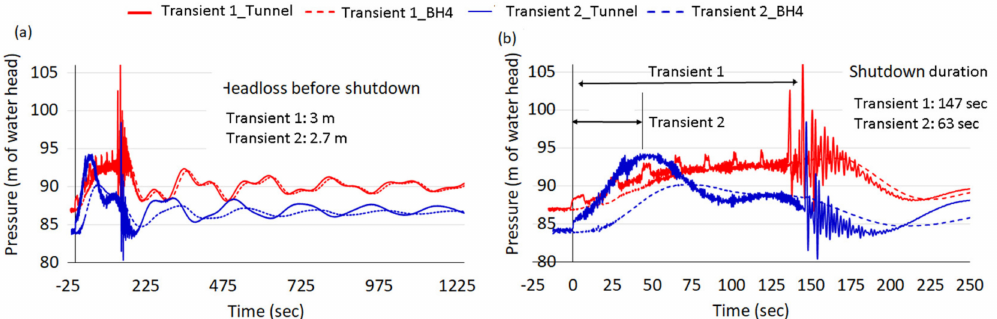
Figure 10. Comparison of pressure signals of two normal shutdowns ( a ) and enlarged view until 250 sec ( b ).